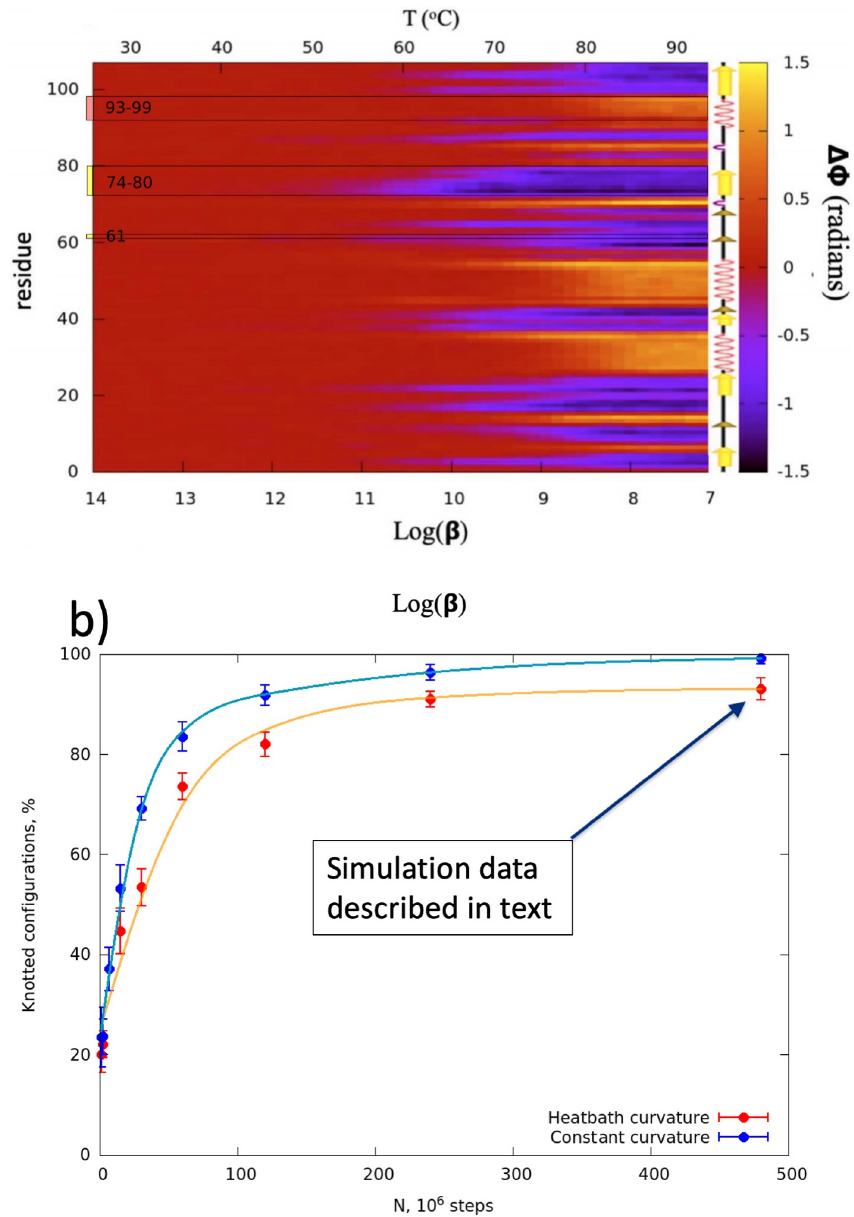
Fig 6. Panel a) characterizes the thermal fluctuations Δ ϕ in the torsion angle values along the entire chain during the entire heating stage. The Δ ϕ value is defined as the difference between the native value of the torsion angle ϕ and the ensemble average of the corresponding angle at the given log 10 ( β ) value. The β -bridge with residue 61, together with the segments 74-80 and 93-99 discussed in the text, have been marked. Panel b) shows the relative number (in percentage) of slipknotted structures in the final folded ensemble, as a function of Monte Carlo steps after one full heating-cooling cycle. The arrow identifies the ensemble that we have analyzed in detail; in this ensemble around 94 per cent of final structures fold into the slipknotted multi-soliton of 2J6B. A movie that shows the (un)folding of a slipknotted structure can be found in S1 Movie. There we also show two examples of misfolding trajectories. In the S2 Movie with no knotted structure in the final stage, and in the file S3 Movie the misfolded state is a trefoil. Misfolding into an unknotted structure is a generic misfolding event. Despite appearing as a folding intermediate, a misfold into a trefoil final conformation is a very rare event in our